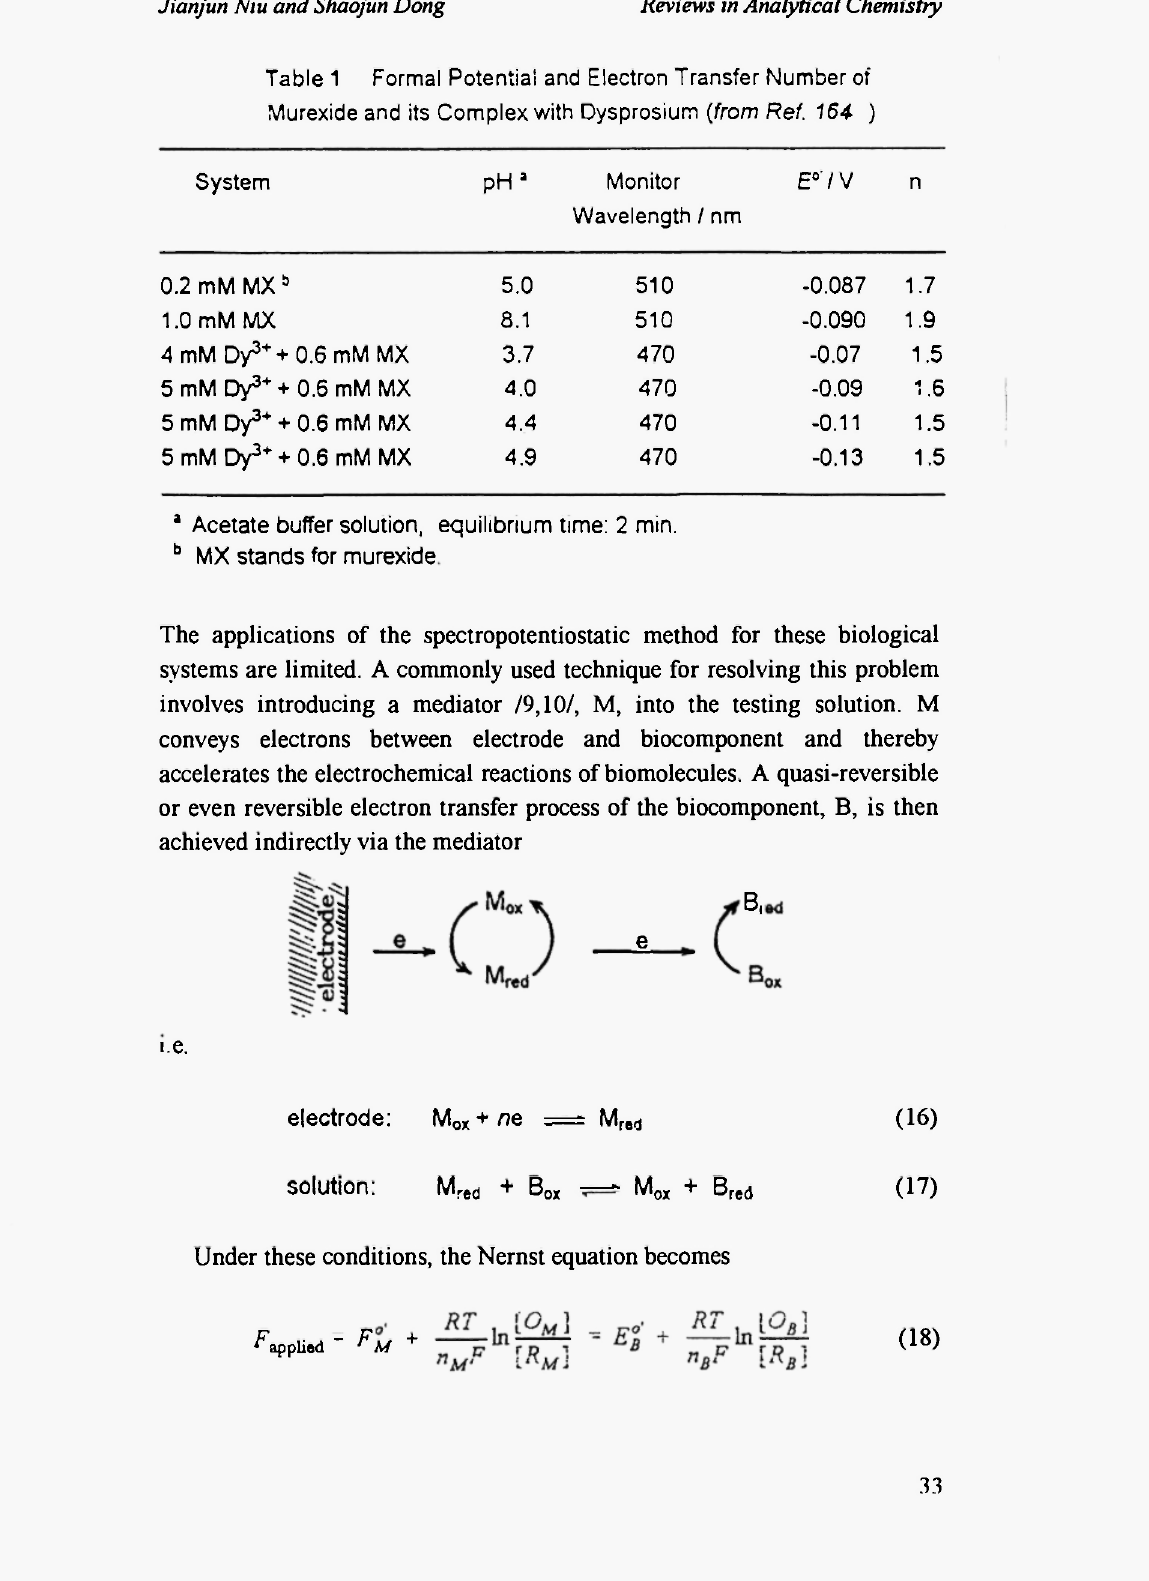
Formal Potential and Electron Transfer Number of Murexide and its Complex with Dysprosium ( from Ref. 164 ) System pH a